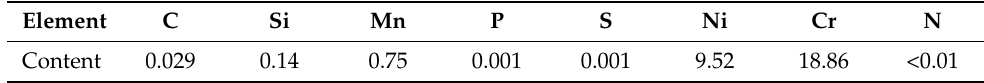
Table 1. Chemical composition of F304LN base material (wt%). Table 1. C hemical composition of F304LN base material (wt%).